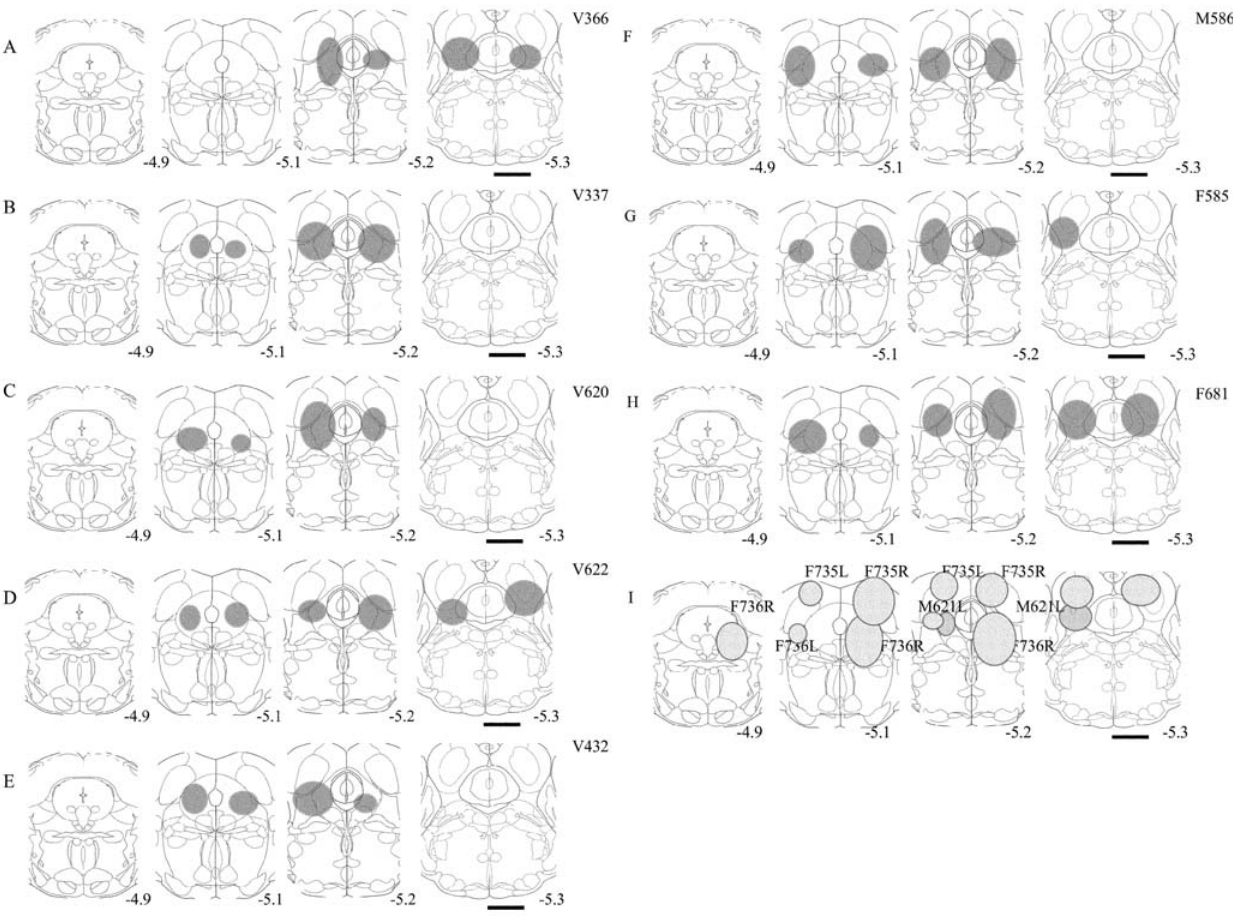
Figure 1. Schematic representation of the extent of lesions as defined by the boundary of loss of NeuN staining in the HCRT -ko mice. The lesions shown in A-H resulted in a significant increase in REM sleep, whereas in 3 mice (shown in I) the lesions did not significantly change REM sleep compared to the saline injected (no lesion) HCRT -ko mice. Scale bar=1.0 mm.